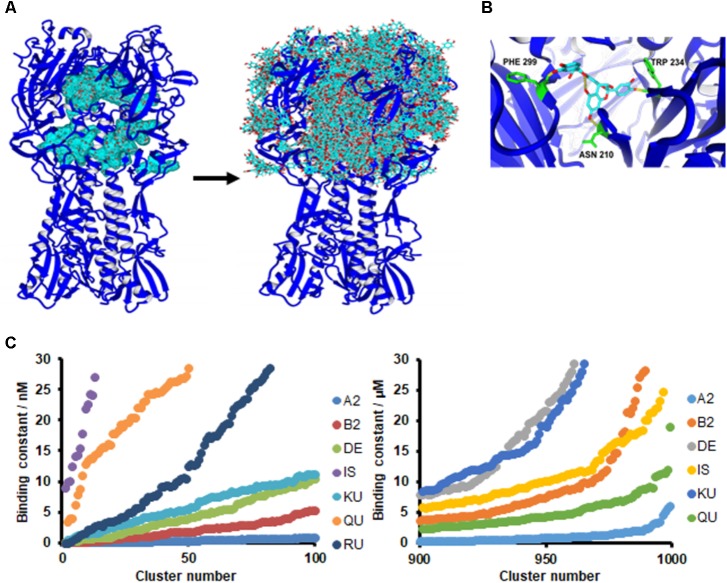
PAC-A2 interacts with HA in an in silico model. (A) Binding of PACA2 to HA-IAV. Crystal structures of HA-IAV (A/Puerto Rico/8/34-PDB ID: 1RU7) and PAC-A2 were docked using the AutoDock algorithm, embedded in YASARA. Docking analysis revealed that PAC-A2 binds within the internal grooves of the HA structure first (left panel) and subsequently to the surface of the structure (righ panel). (B) Best pose of PAC-A2 to HA-IAV. This represents the best complex obtained after 999 docking runs. The HA-IAV structure is represented in blue; PAC-A2 is in cyan; residues forming hydrogen bonds to the ligand are in green; and hydrogen bonds are in yellow. (C) PAC-A2 is the Oximacro® component that binds best to HA. Chemical structures of different components of Oximacro® were subjected to docking analysis. PAC-A2 (A2), PAC-B2 (B2), Delphinidin 3-glucoside (DE), Isorhamnetin (IS) Kuromanin (KU), Quercetin (QU), and Rutin (obtained from Pubchem) were docked with HA. In the left panel, the distribution of the binding constants of the top 100 scoring complex clusters is shown; in the right panel, the distribution of the worst 100 scoring complexes is shown. In the right panel, Rutin is not shown because its binding constant was >30 μM.